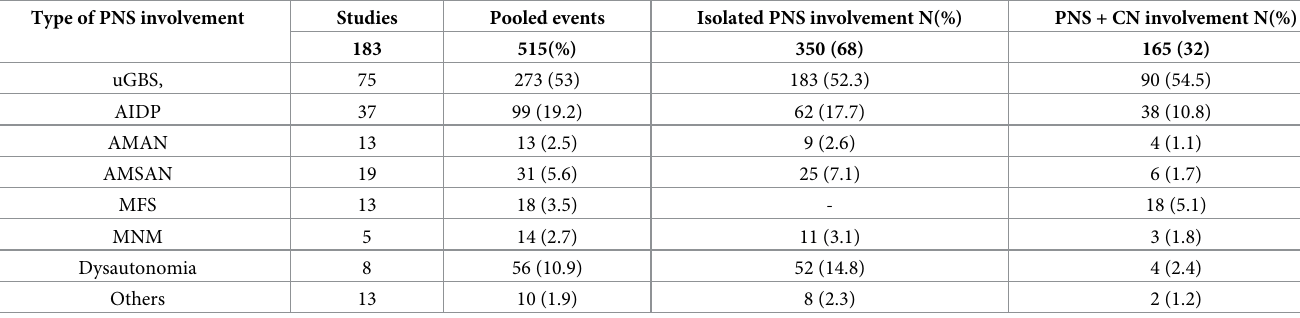
Table 3. Type of PNS involvement in patients with COVID-19.